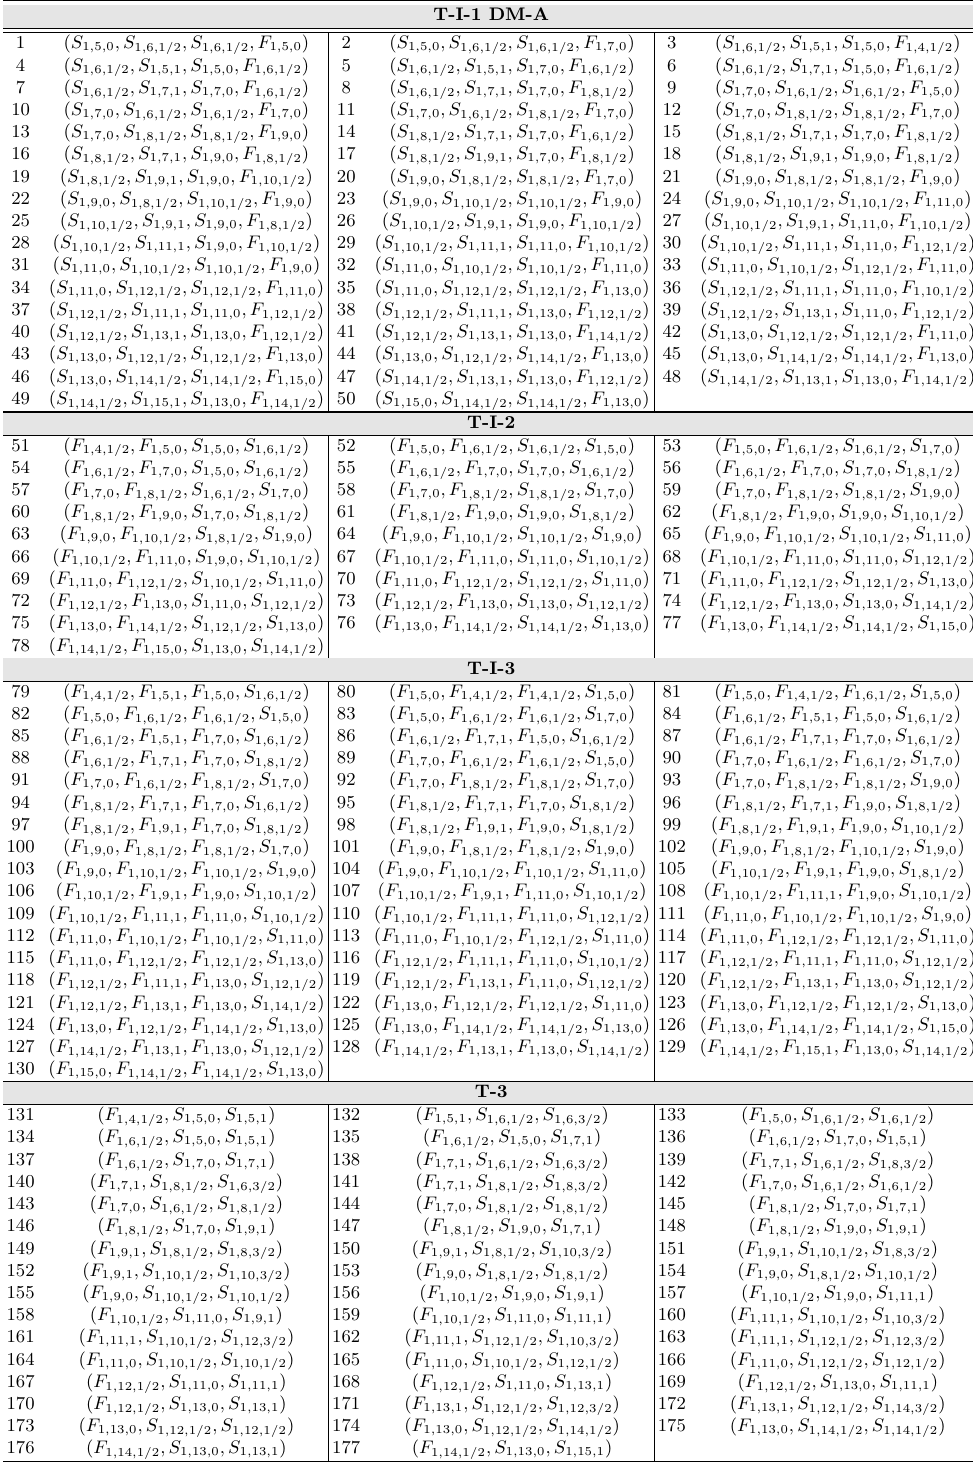
Table 9 . Models in which the DM could be stable due to accidental symmetry